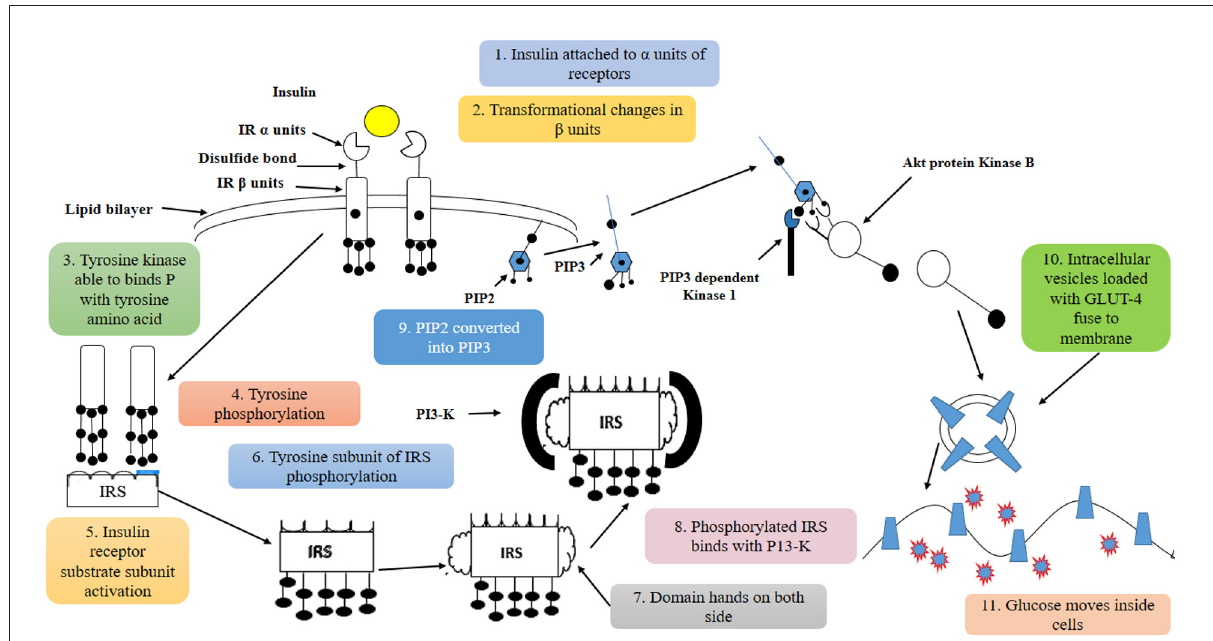
FIGURE2 Insulin binds to insulin receptors α units which cause phosphorylation of insulin β units. After activating the insulin receptor substrate subunit, P13-K is attached to domain hands on both sides. This procedure activates Akt protein kinase B, which plays an important role in transferring glucose inside the cells.